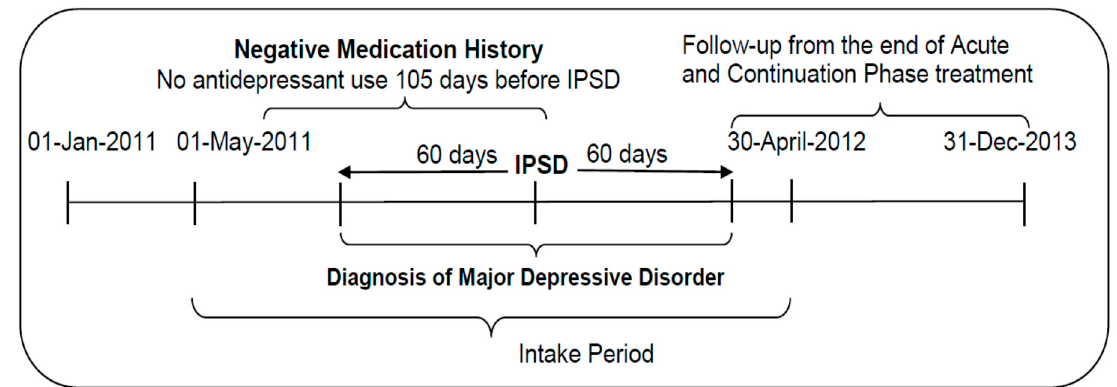
Figure 1. Diagram of the study design.